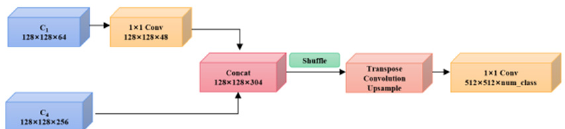
Figure 7. Schematic diagram of the ASPP module.